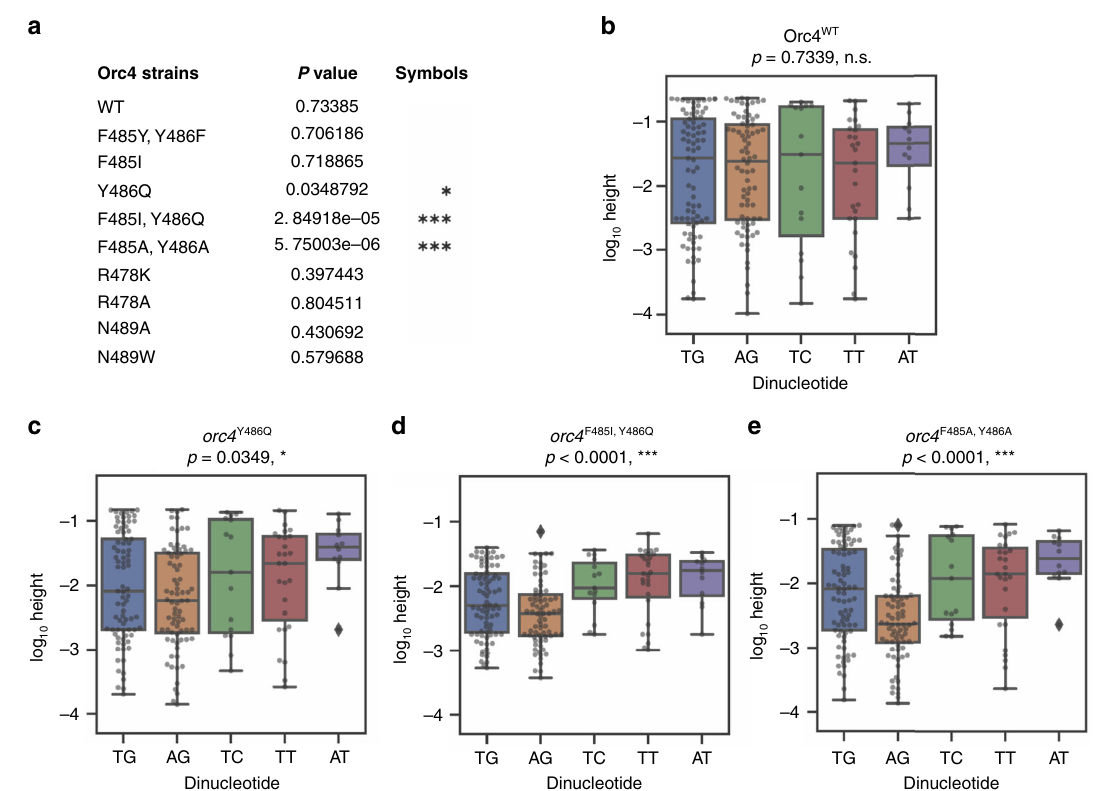
Fig. 4 Genomic origin fi ring pattern changes are sequence speci fi c. DNA sequences under each of the origin replication peak that match the ARS consensus sequence (ACS) motif were obtained from OriDB 13,19 . Genome-wide statistical analysis was performed to check the dependence of origin fi ring peak height on dinucleotide identity at positions 29 – 30, which were chosen based on the results of our MPOS analysis (Fig. 2c), using a one-way ANOVA test for dependence. There were 5 dinucleotide variants that occurred 3 or less times in 9 annoated ACSs were removed prior to this analysis. In the remaining n = 211 annotated ACSs, there were 5 dinucleotide variants at 29 – 30; these were analyzed and the peak heights for each dinucleotide are plotted. Asterisks denotation: * p < 0.05, ** p < 0.01, *** p < 0.001. a Genome-wide statistical analysis results for all ten strains. b – e Box plots for Orc4 wild- type ( b) and three of the orc4 mutant strains ( c – e) . Y -axis shows genomic log 10 peak heights. Each dot denotes an annotated ACS. Box plots elements: the minimum height, fi rst (lower) quartile, median, third (upper) quartile, and maximum height. Diamonds denotes outliers that exhibited aberrantly large values. The “ AG ” dinucleotide at position 29 – 30 is not utilized in mutants that change Y486 to alanine or